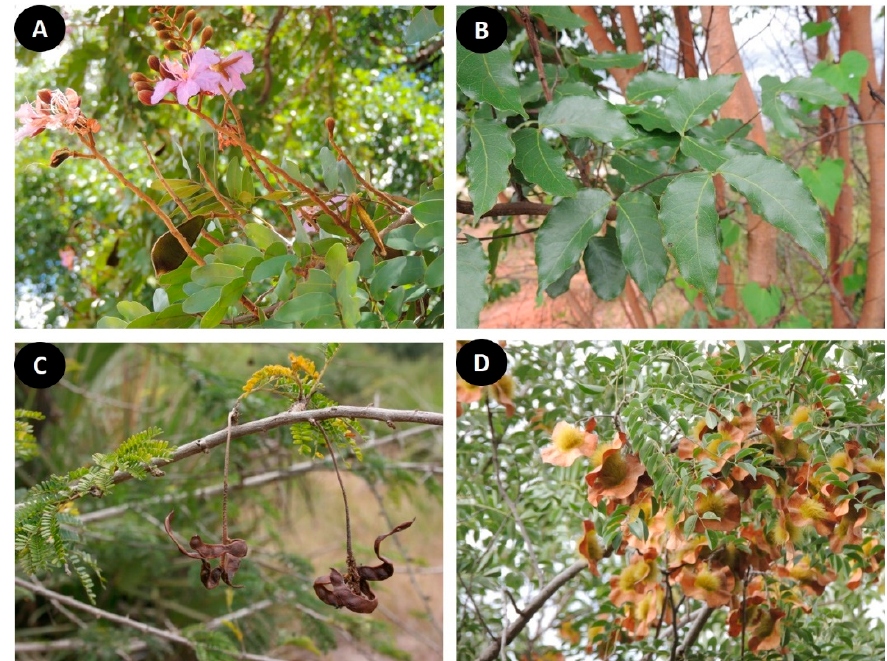
Figure 2. Leguminosae species from Miombo and Mopane woodlands and their conservation status according to the IUCN Red List. ( A ) Baikiaea plurijuga occurs in Miombo and Mopane woodlands and is classified as near threatened; ( B ) Brachystegia bakeriana occurs in Miombo and is classified as vulnerable; ( C ) Dichrostachys cinerea occurs in both ecoregions and is classified as least concern; ( D ) Pterocarpus angolensis occurs in Miombo woodlands and is classified as near threatened.